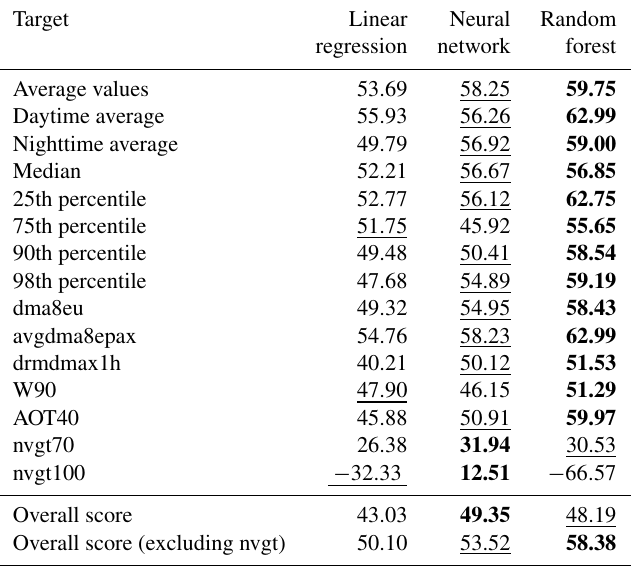
Table 3. R 2 scores of the test set in percent. Best results are marked in bold; second-best results are